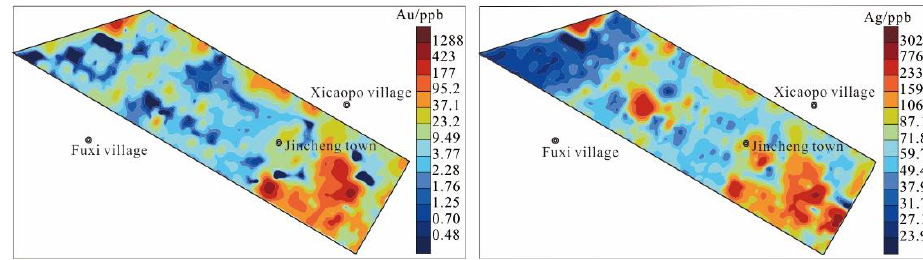
Figure 12. Geochemical map of the fine-grained soil prospecting method in Qujia Au deposit.